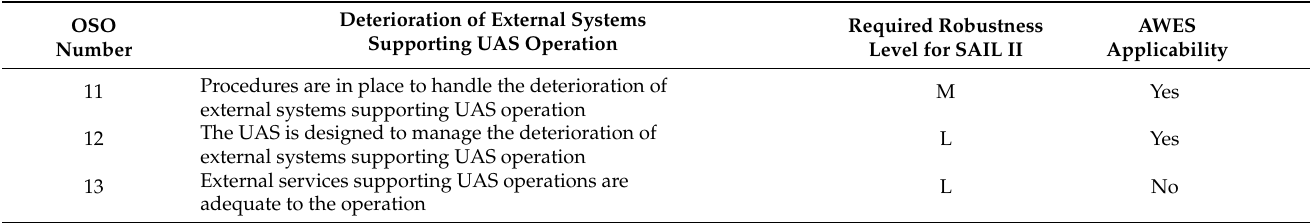
Table 11. Recommended operational safety objectives (OSO) in the SORA and their applicability to commercial AWES, compiled from [20].